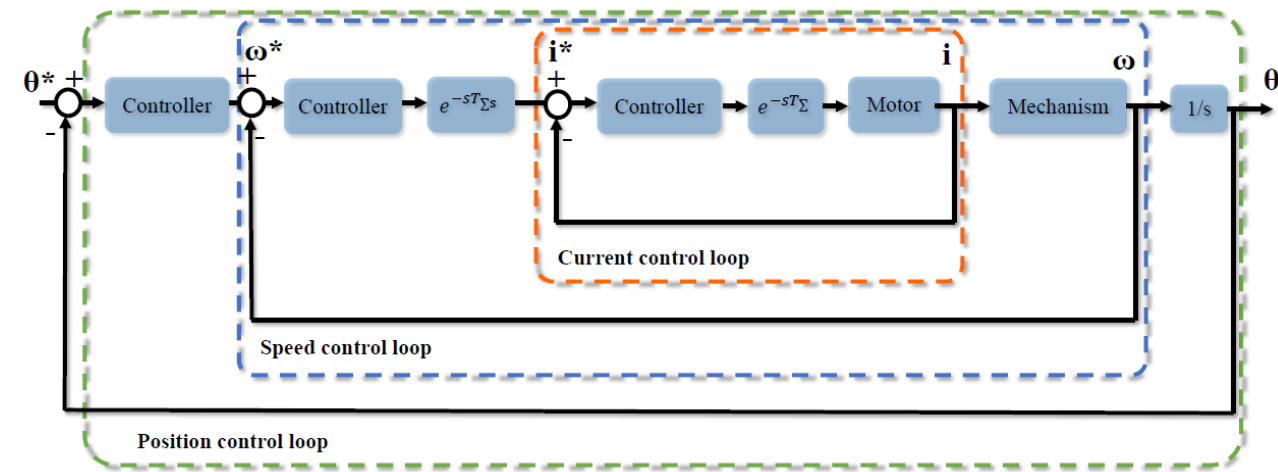
Figure 13. Control system architecture of the LLRE-II.